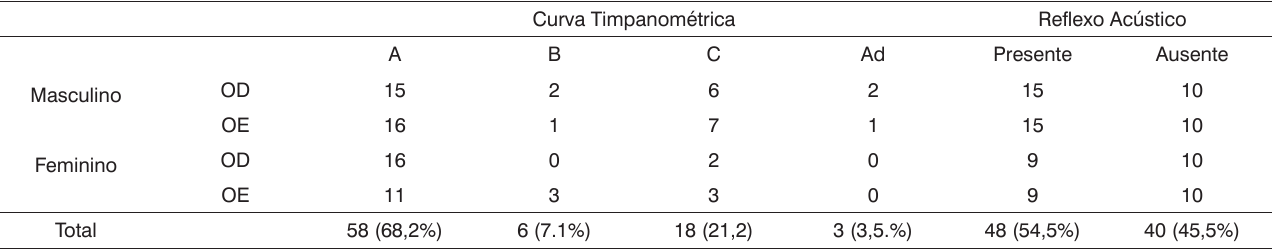
Tabela 3. Crianças fissuradas do sexo masculino e feminino, segundo o resultado da imitanciometria, nas orelhas direita (OD) e esquerda